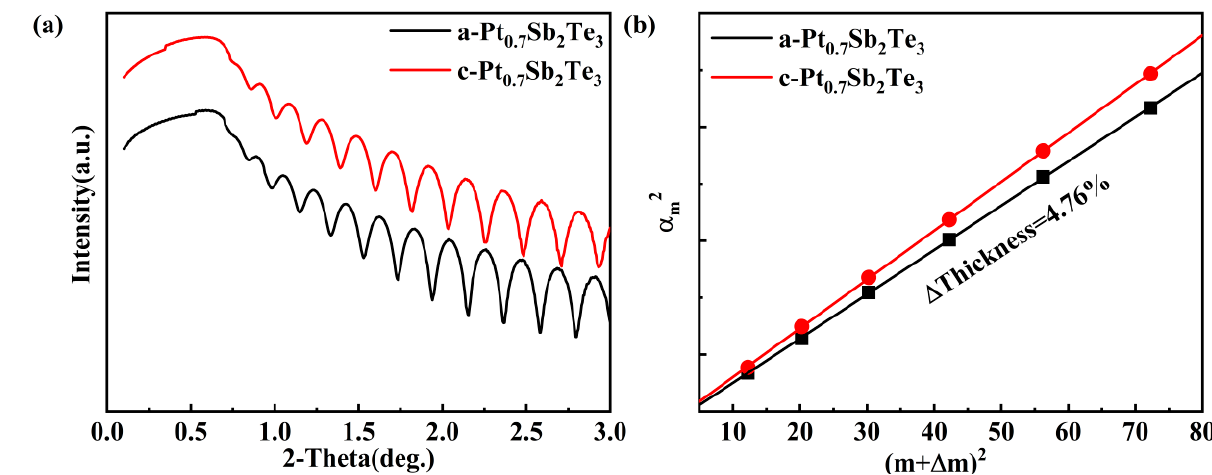
Figure 4. The density − change rate before and after PST crystallization ( a ) XRR curves of amorphous and crystalline PST films. ( b ) Bragg fitting curves of amorphous and crystalline films.